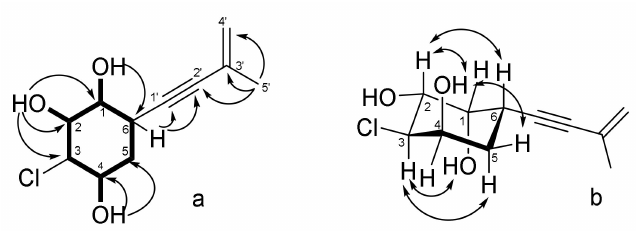
Figure 2. Key 1 H– 1 H COSY, 1 H– 13 C HMBC ( a ) and ROESY ( b ) correlations of 1